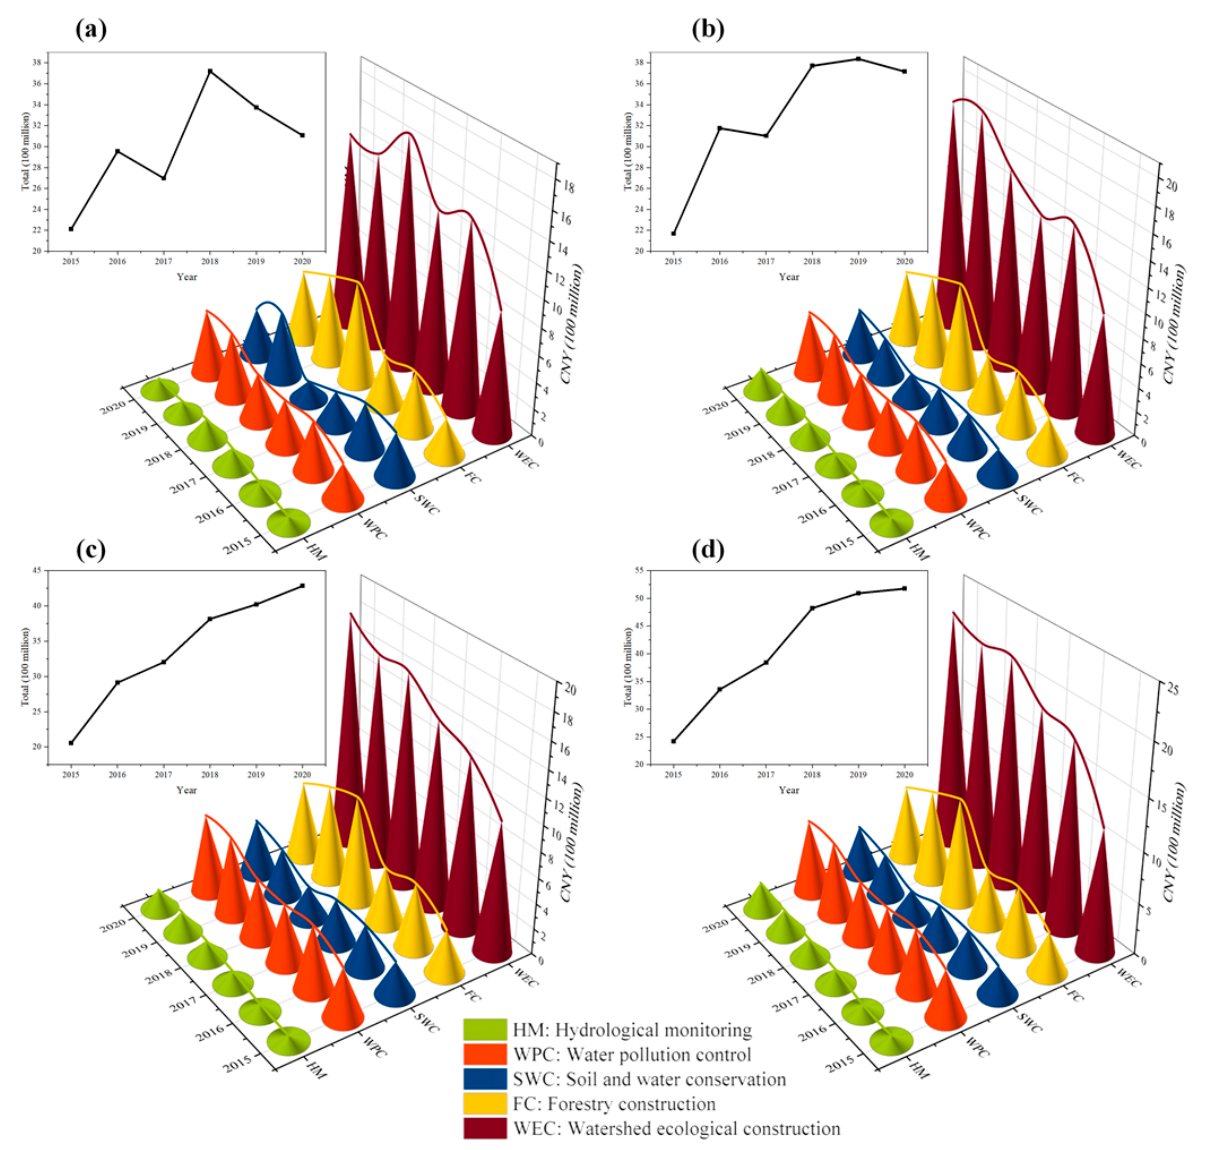
Figure 2. Direct input costs of ( a ) Hanzhong, ( b ) Ankang, ( c ) Shangluo, and ( d ) Shiyan among the main headwater areas from 2015 to 2020.